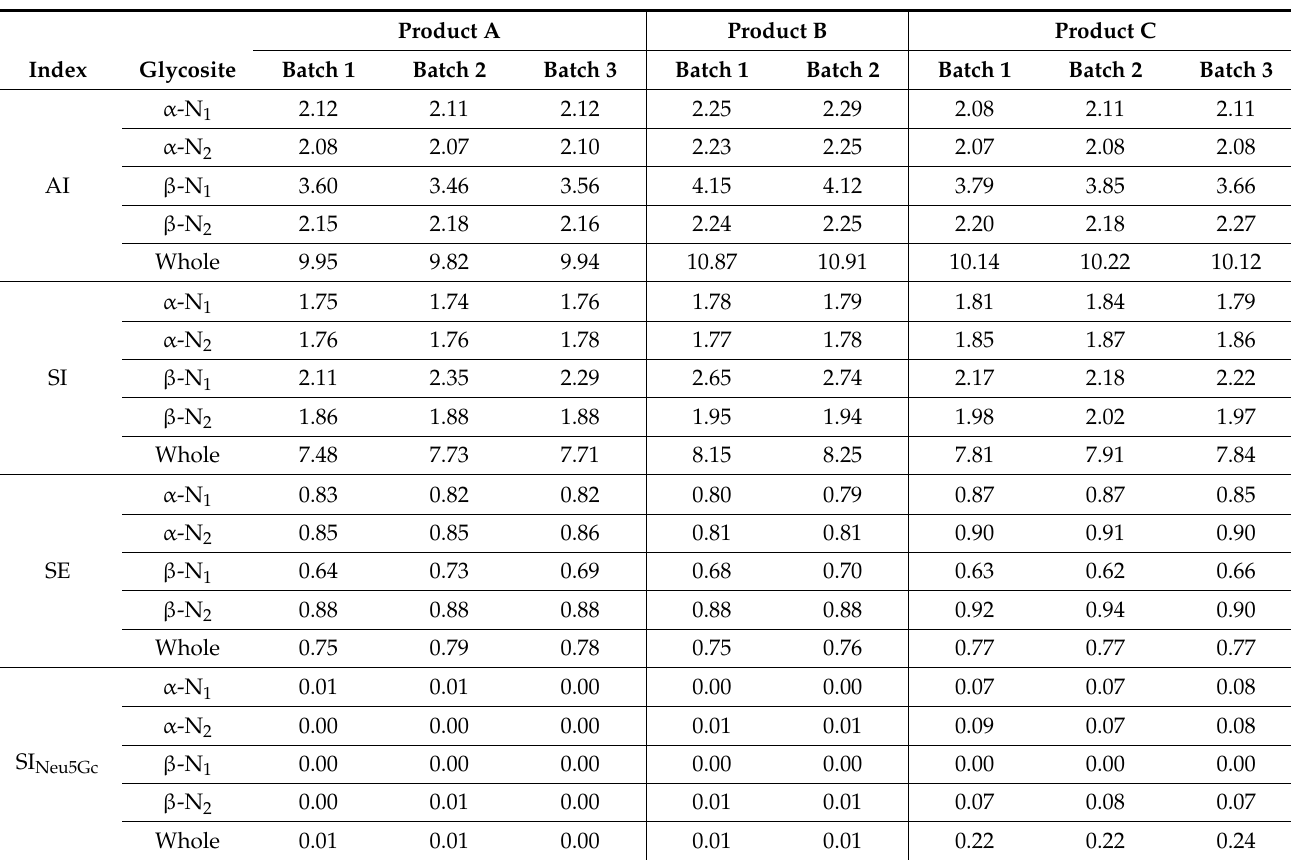
Table A2. FSH comparative matrix of three recombinant FSH products (Product A and C: three batches tested; Product B: two batches